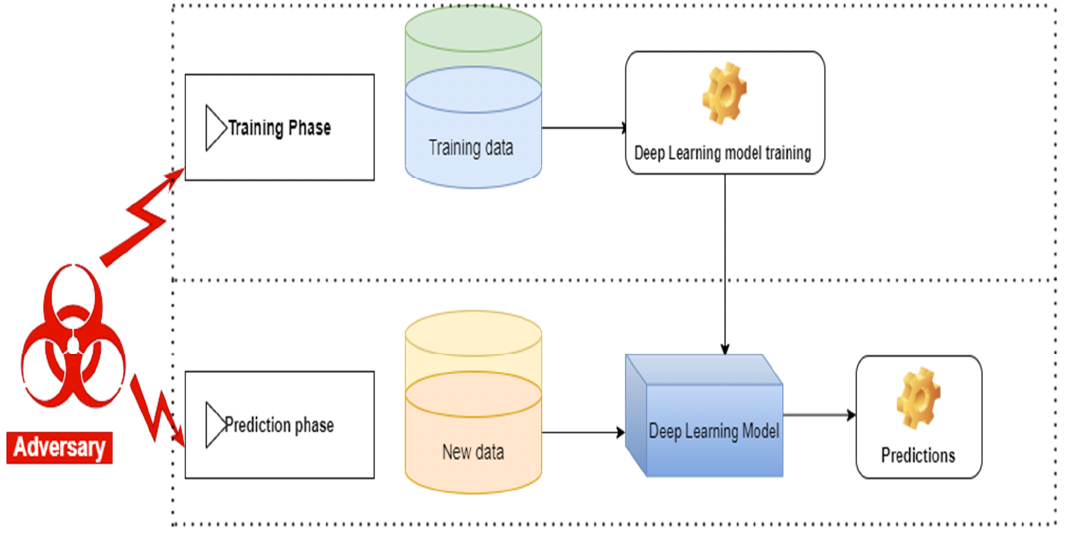
Figure 2. Adversarial machine learning. Reproduced with permission from [13], CEUR (http://ceur-ws.org/Vol-2057/), 2017. Adversarial attacks can be categorized based on the adversary’s goal or based on the adversary’s knowledge. Classification of adversarial attacks based on adversarial goals